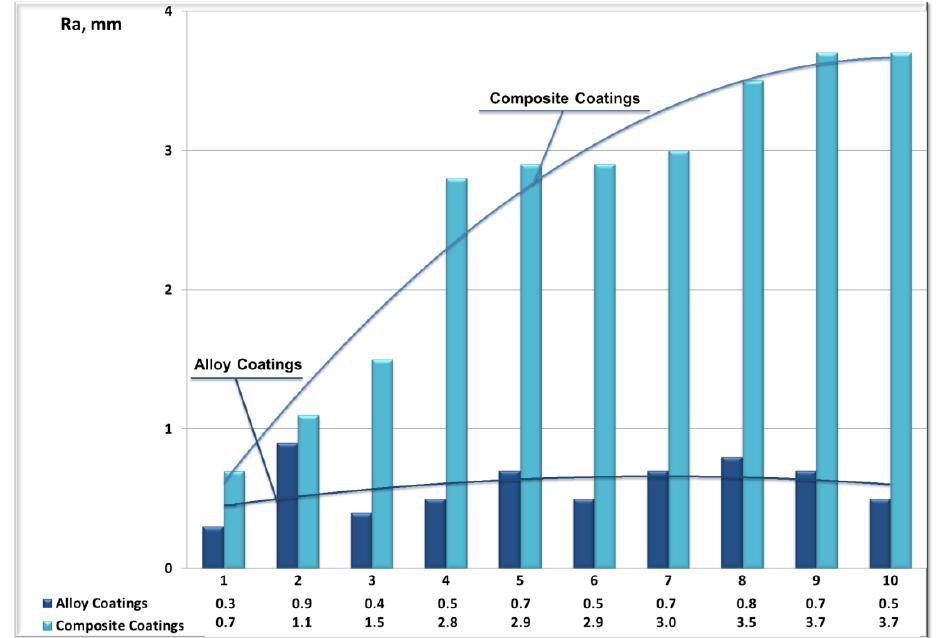
Figure 1. The roughness parameter Ra for alloy coatings and for composite coatings for surface after turning samples’ inserts according to the study program (Table 1).